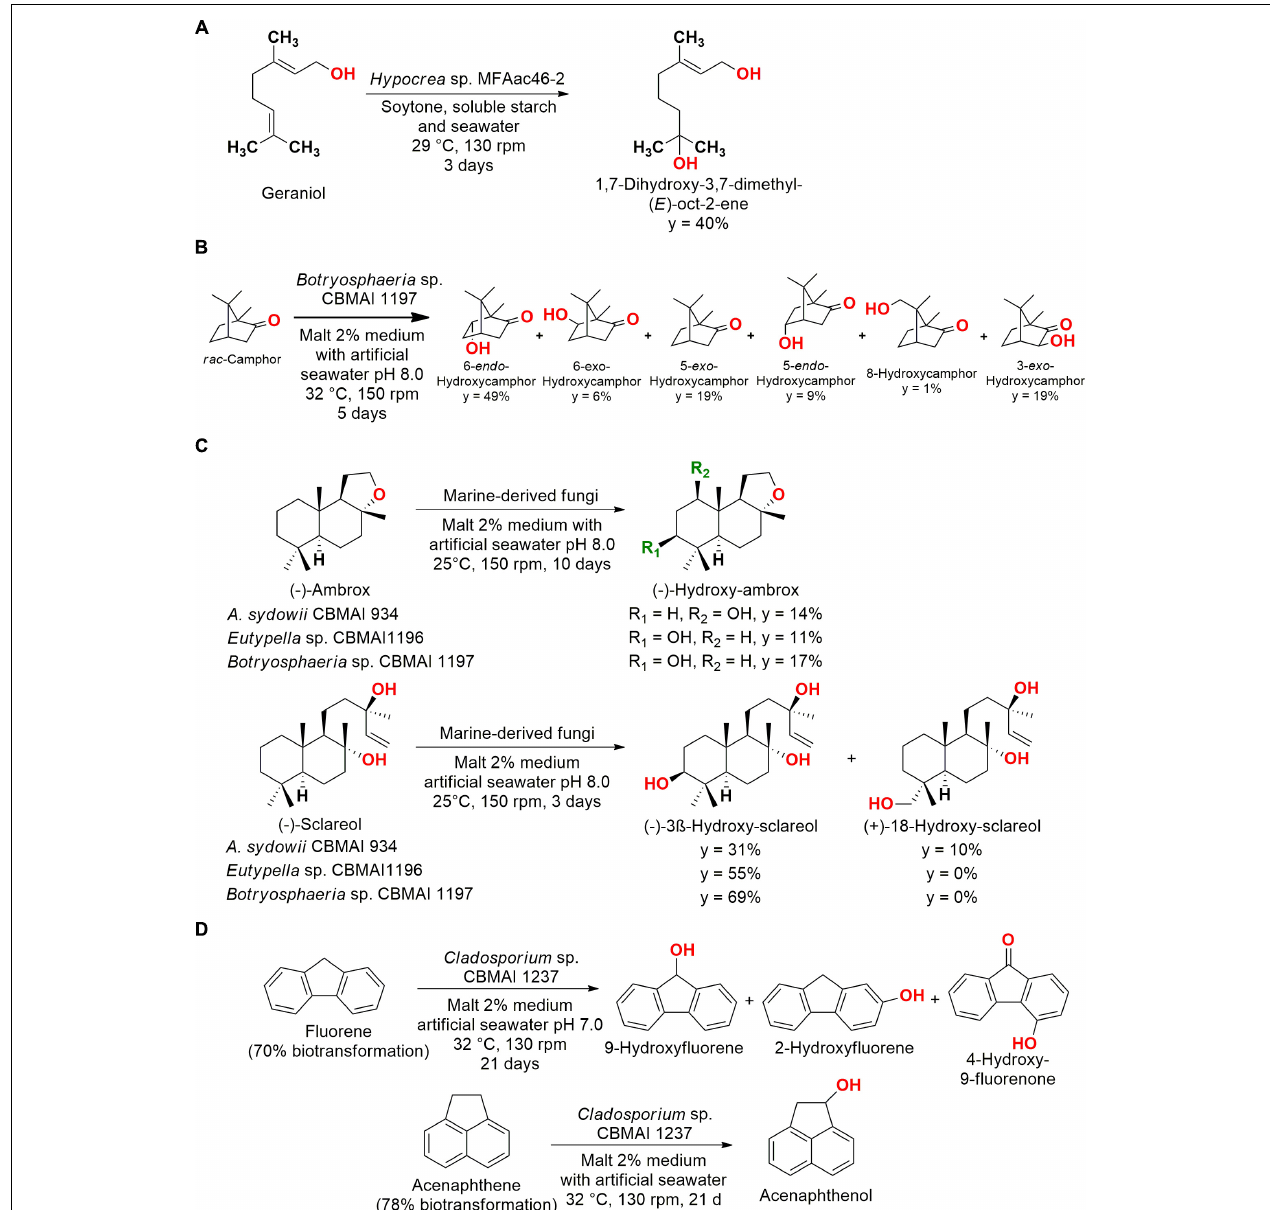
FIGURE 5 | (A) Hydroxylation of geraniol by Hypocrea sp. MFAac46-2 (Leutou et al., 2009). (B) Hydroxylation of rac -camphor by Botryosphaeria sp. CBMAI 1197 (De Jesus et al., 2017). (C) Biotransformation of (–)-Ambrox and (–)-Sclareol by marine-derived fungi (Martins et al., 2015). (D) Biotransformation of fluorene and acenaphthene by Cladosporium sp. CBMAI1237 (Birolli et al.,